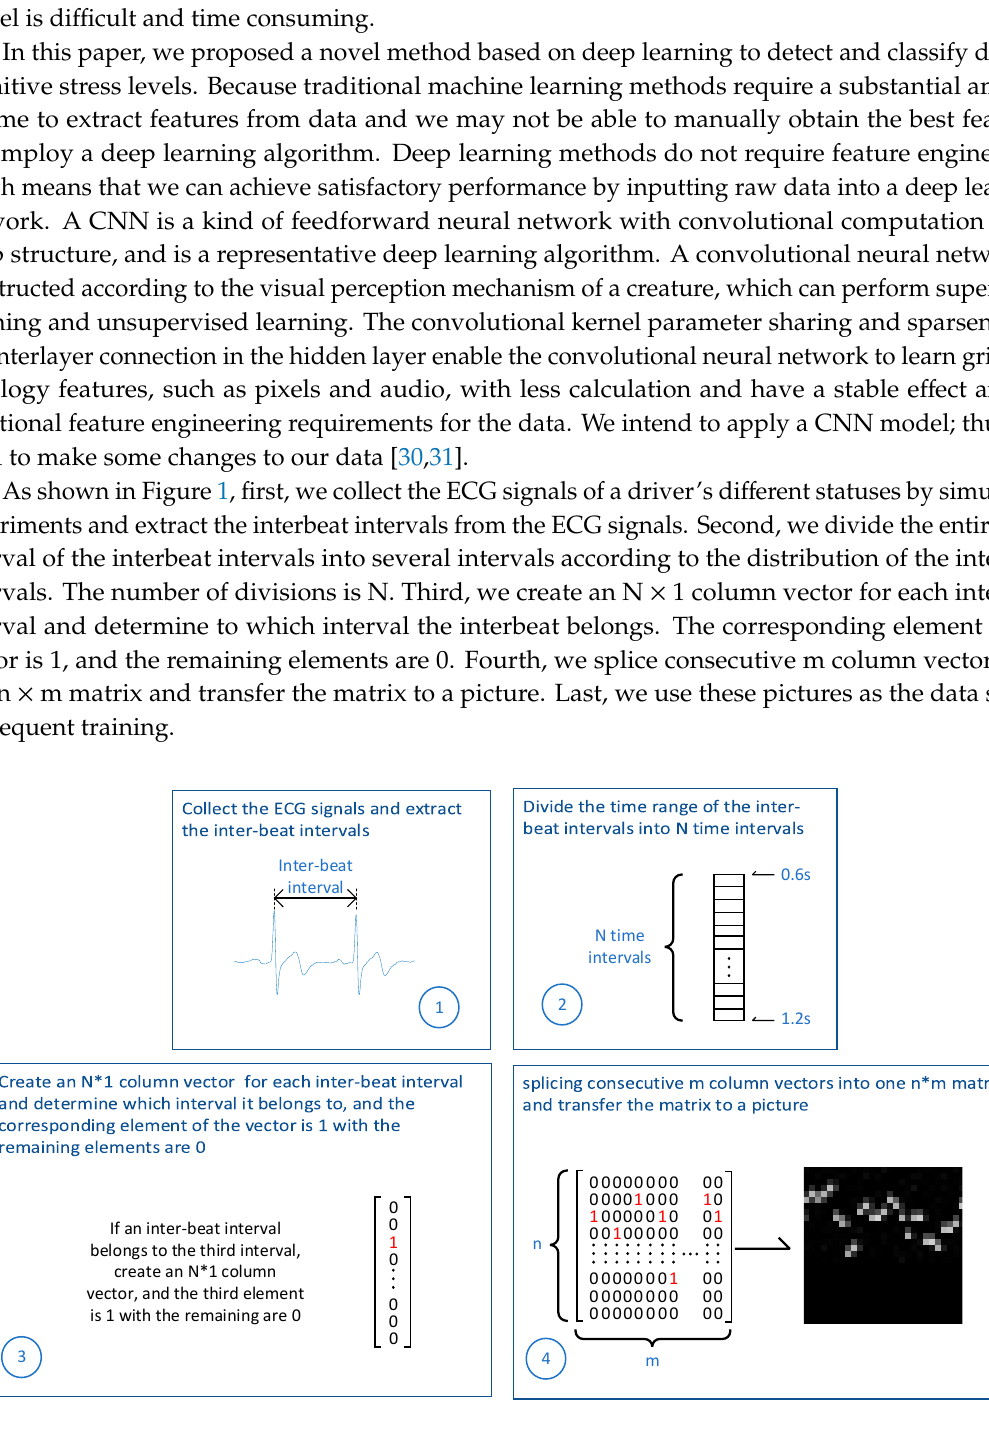
Figure 1. A novel classification method for a driver’s cognitive stress level.